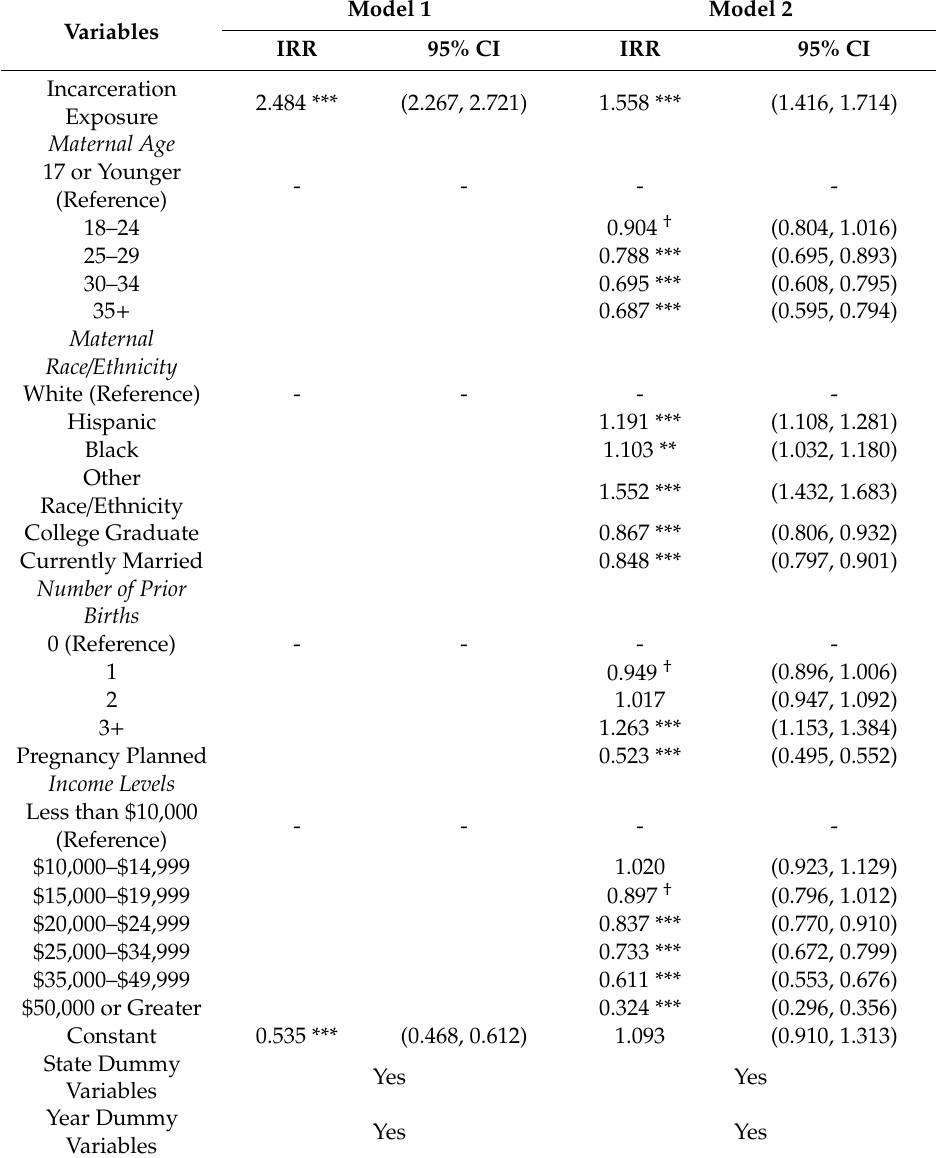
Table 2. Results of Negative Binomial Regression of Incarceration Exposure on Number of Prenatal Care Barriers ( N =